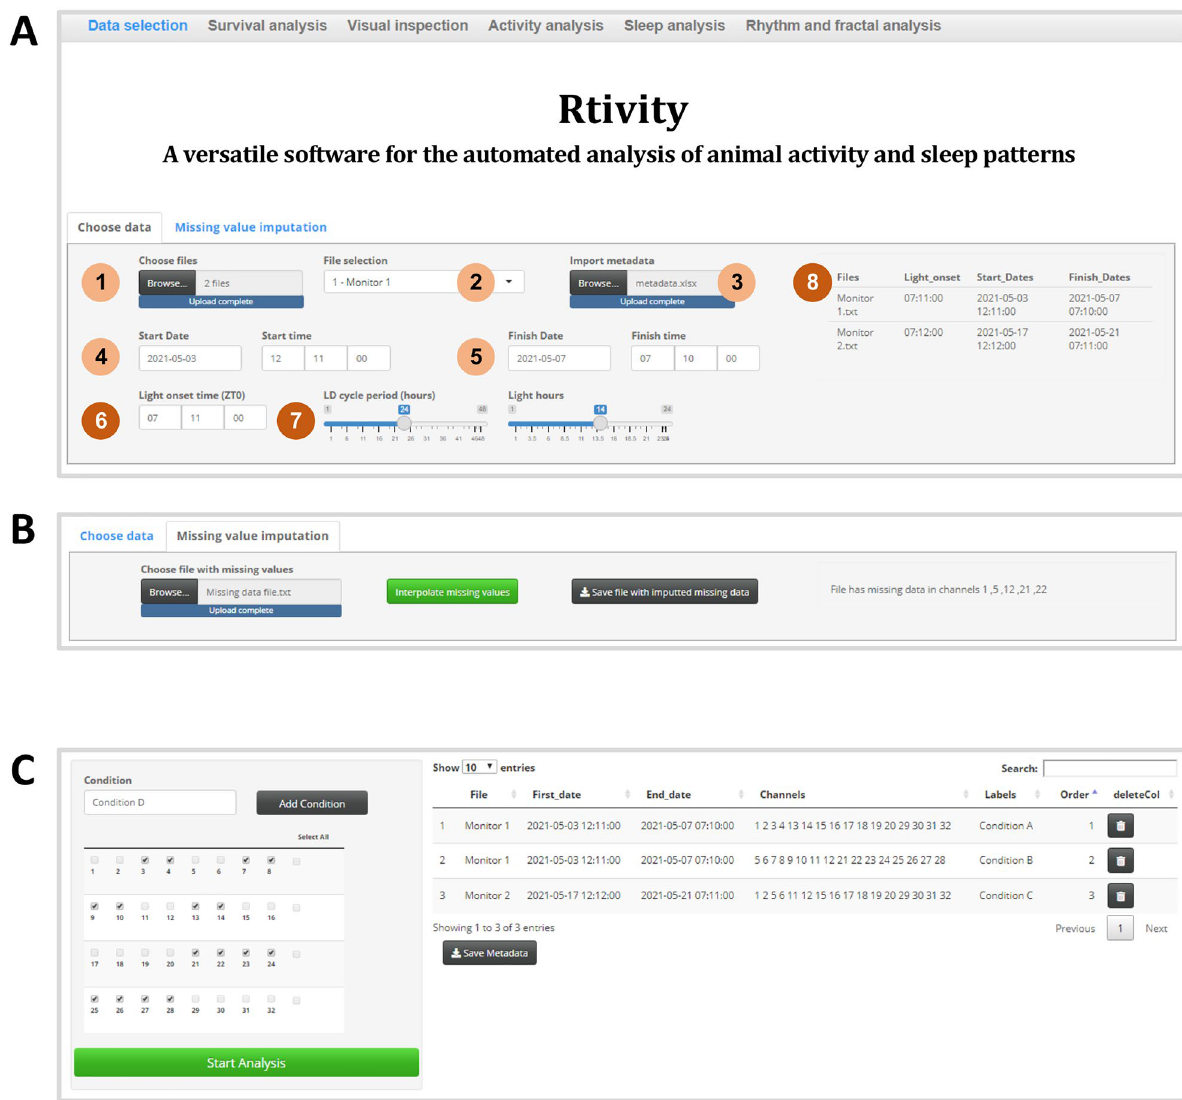
Figure 1. Rtivity interface. ( A) Selection of files and analysis parameters: (1) file import; (2) file selection; (3) import metadata; (4) start date; (5) finish date; (6) light-onset time (zeitgeber time zero; ZT0); (7) light–dark (LD) cycle period and light hours per cycle; (8) display of files selected for analysis and their corresponding ZT0. ( B) Missing values imputation. Users can upload the file, check the status message for missing values, select the option to interpolate, and save as a new monitor file. ( C) Channel selection and grouping into experimental conditions: (left) each of the 32 channels of a LAM or DAM system can be freely selected into a user-labelled condition; (right) display of the metadata for each condition (original filename, dates, channels, condition labels, and order of conditions in the graphs), which will be imported to the Rethomics libraries for downstream analysis. Images in Figure contain screenshots of the Rtivity software developed in this study (https:// ruisi lva. shiny apps. io/ rtivi ty/), assembled and illustrated by co-authors RS and JMAO using version 2.8.22 of the free image editor GIMP (https:// www. gimp.